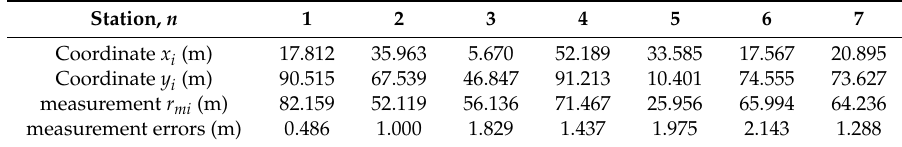
Table 1. The base station coordinate and distance measurement to the tag ( k = 2.5, P = 96%, σ i = 1 m). Station,